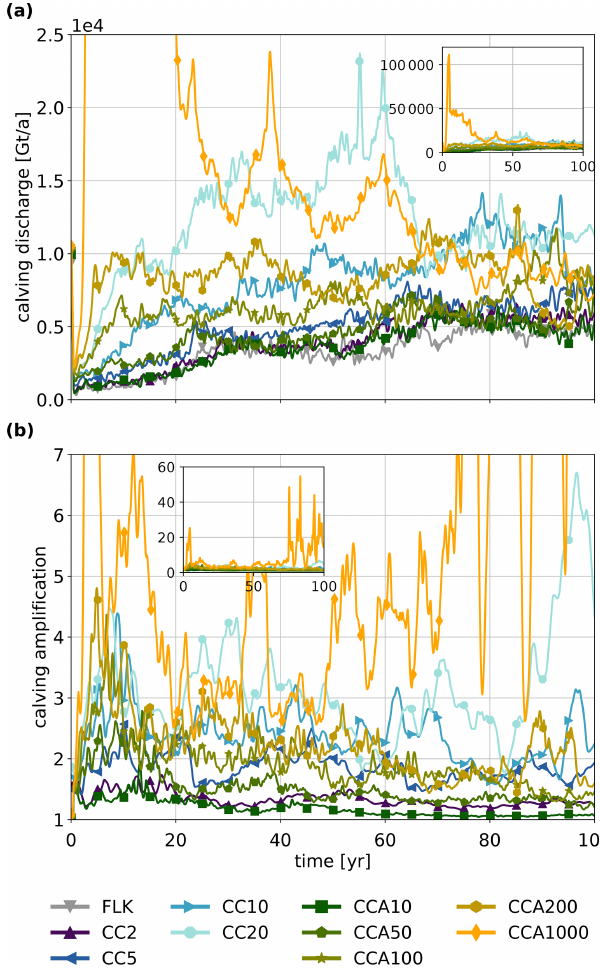
Figure 4. (a) Overall calving discharge from the Amundsen region. PISM uses a subgrid scheme at the ice margin with partially filled cells (Albrecht et al., 2011). At each time step, calving removes some of the ice in such a cell, whereas floatkill removes whole cells if they float. This removed ice volume is summed up in the calving discharge variable. (b) The calving amplification calculated as the fraction between overall calving discharge and calving discharge due to the floatkill parameterization only. Note that no calving am- plification has been calculated for the floatkill-only experiment be- cause no cliff calving takes place. The calving amplification of the CC20 and the CCA1000 experiments increases toward the end of the simulation time because parts of the grounding line have reached the margin of the inner WAIS region, beyond which cliff calving and the floatkill mechanism are not